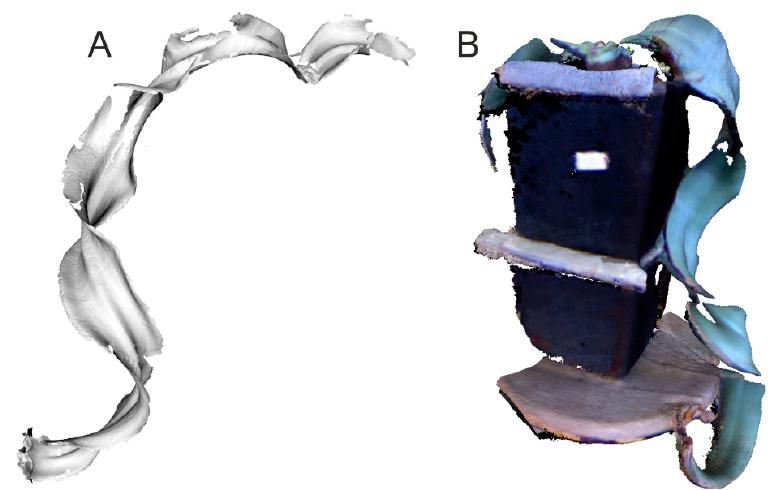
Figure 7. Model of a Welwitschia mirabilis leaf obtained with: ( A ) A hand-held and ( B ) Kinect scanner.